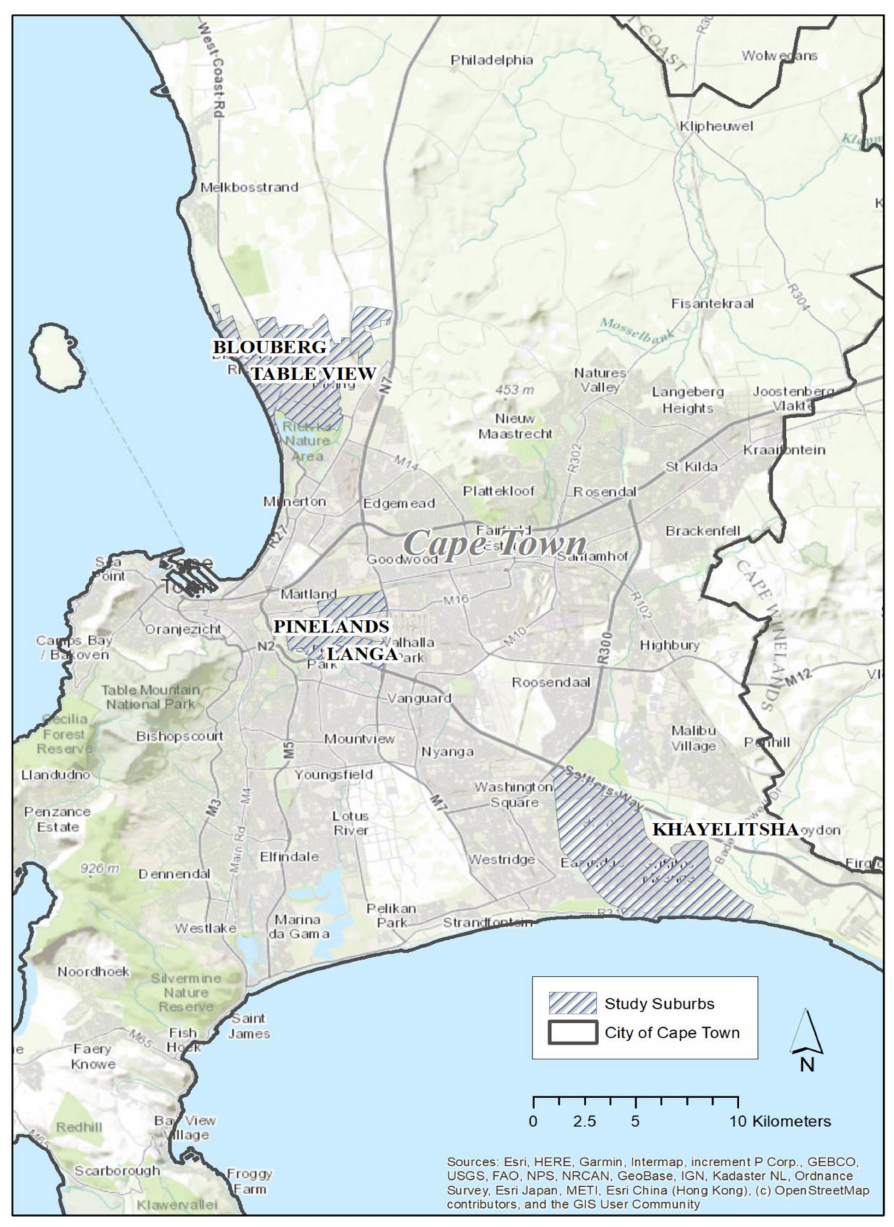
Figure 1. The map of visual representation of Cape Town, with the four study